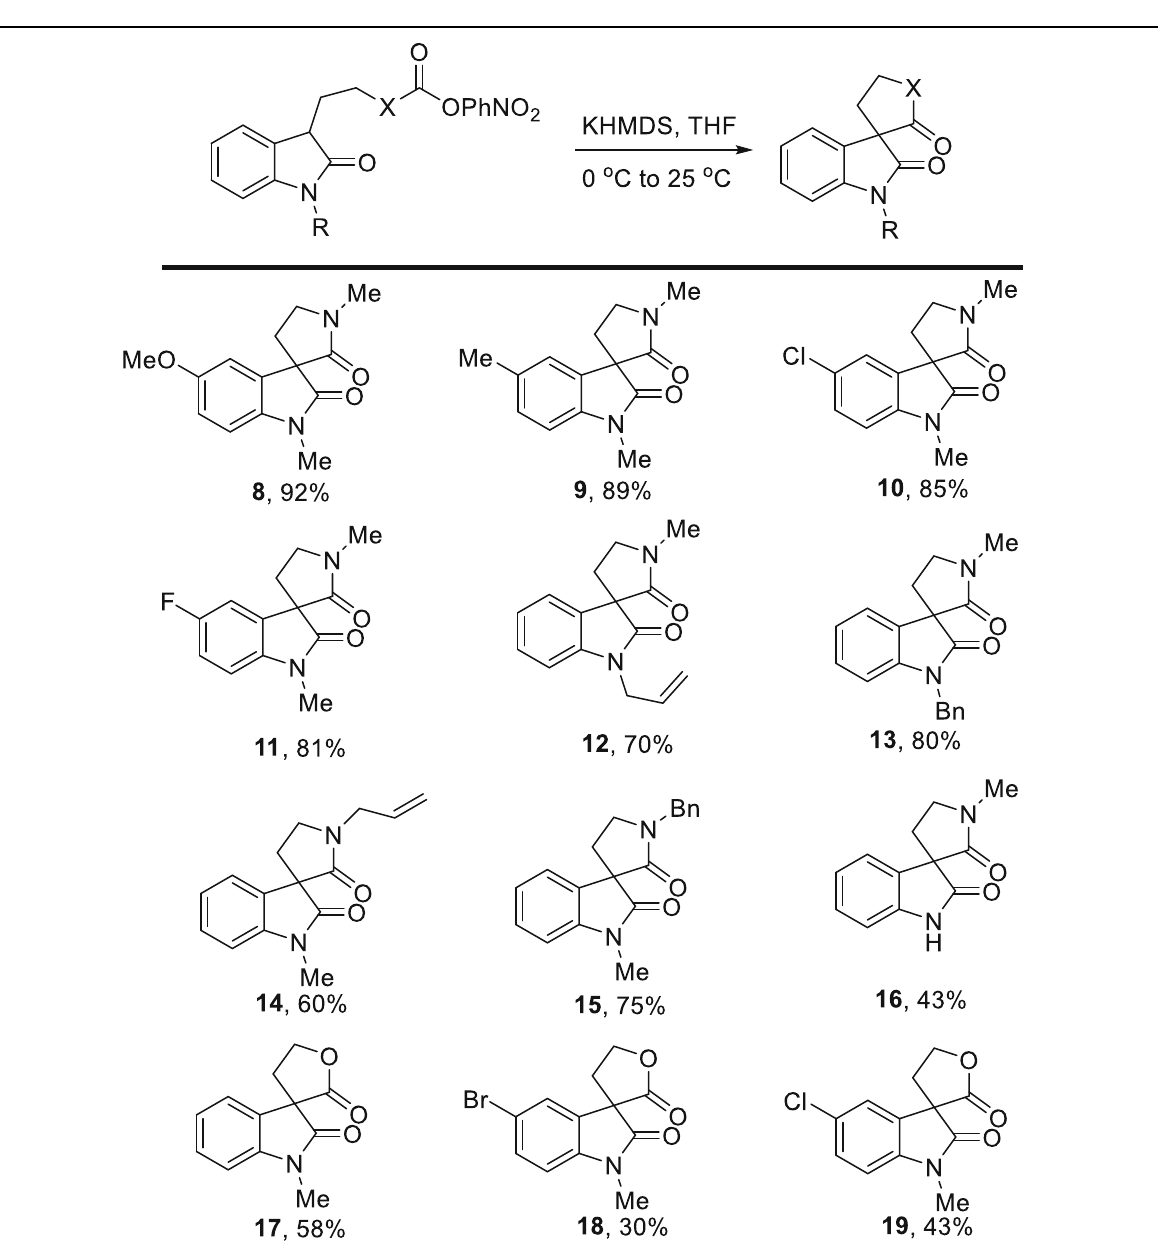
Table 2 Substrate scope of the